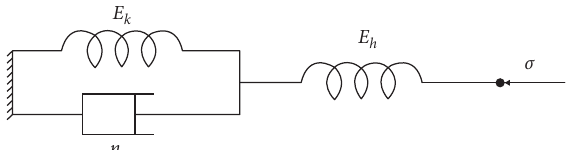
Figure 3: Generalized Kelvin model for viscoelastic deformation